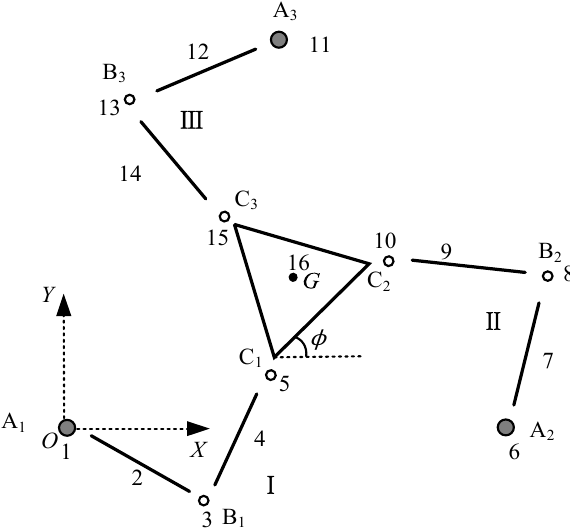
Figure 3. DT-TMM model of 3-RRR PPM.